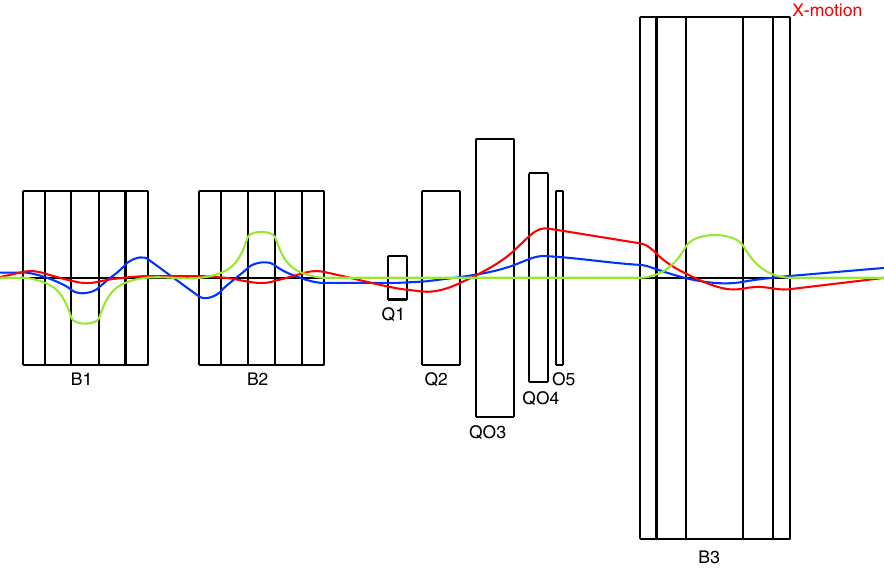
FIG. 4. Principle in-plane rays for the full system [initial rays are x ¼ 3 mm (blue), p x ¼ 10 mrad (red), and Δ p=p ¼ 10% (green)]. The full width of B1, B2 and B3 are 10, 10 and 30 cm,